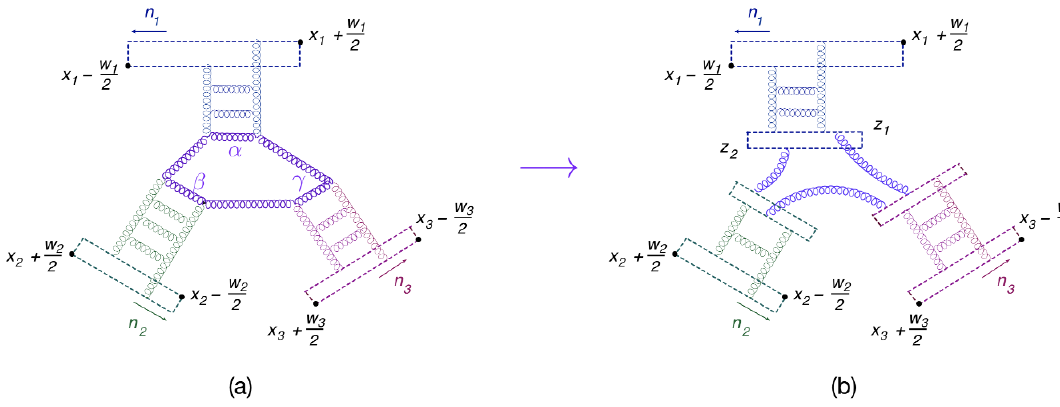
Figure 6 . Correlator of three Wison frames.